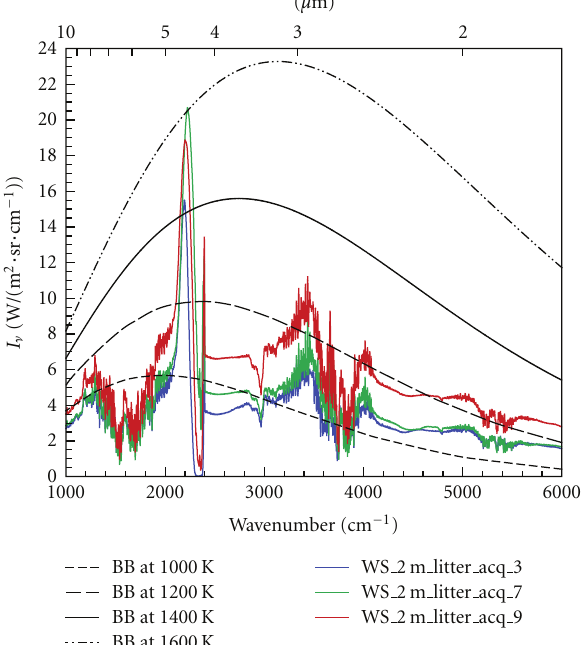
Figure 8: Emission spectra resulting from the burning of the 2m longWS fuel bed, with a line ofsight coming from the burning litter. The fuel load is 1 kg/m 2